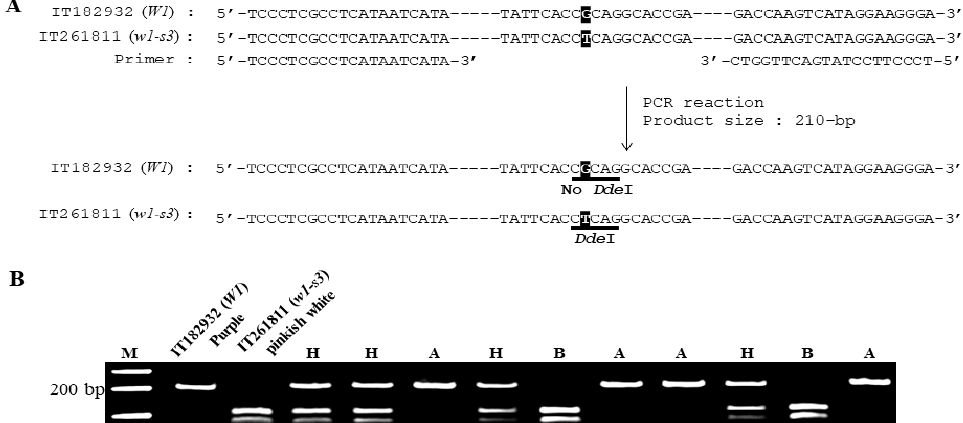
Figure 3. Schematic diagram of CAPS analysis and co-segregation of W1 polymorphism with the pinkish-white flower color phenotype. ( A ) CAPS analysis was aimed to detect an SNP in the w1-s3 allele (T, indicated in white font highlighted in black). The underlined Dde I site (CTNAG) was used for CAPS analysis. PCR products from IT261811 ( w1-s3 ) were 210 bp in length and were digested with Dde I into 112- and 98-bp DNA fragments, whereas those from IT182932 ( W1 ) remained uncut after digestion. ( B ) CAPS analysis shows the co-segregation of W1 polymorphism and the flower color observed in the F 2 population derived from the cross between IT261811 and IT182932. M, a 1-kb molecular marker; H, heterozygous F 2 plants with purple flowers; A, wild-type F 2 plants with purple flowers; and B, homozygous F 2 plants with pinkish-white flowers.